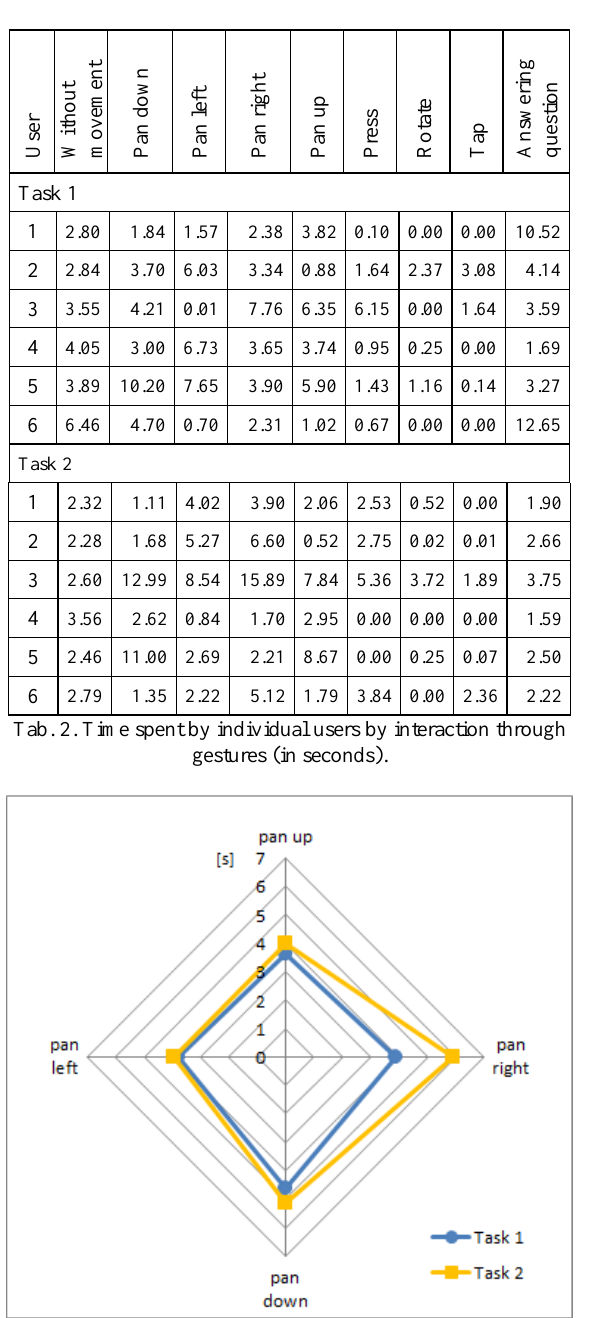
Fig. 5. Average time (in seconds) spent by interaction through pan gesture (divided by direction)